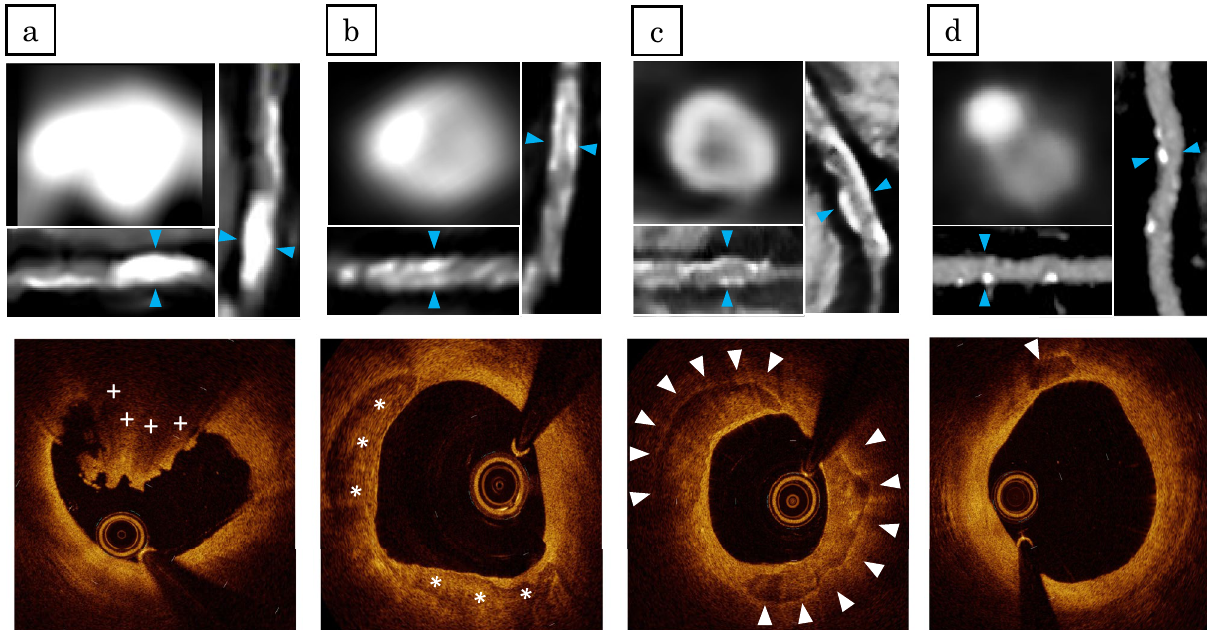
Figure 2. Representative CCTA and OCT images of calcified plaques. ( a ) A representative image of calcified nodule. CCTA image showing a large area of calcification. The area of calcified plaque on the cross-sectional image (at blue arrow heads) is 21.77 mm 2 . The OCT image of this lesion demonstrates calcified nodules (plus symbols). ( b ) A representative image of eccentric calcified plaque. The area of calcified plaque on the cross- sectional image (at blue arrow heads) is 2.8 mm 2 . The OCT image of this lesion demonstrates a superficial calcific sheet (asterisks). ( c ) A representative image of circumferential calcified plaque. CCTA image showing a circumferential calcification. The aread of calcified plaque on the cross-sectional image (at blue arrow heads) is 3.8 mm 2 . The OCT image of this lesion demonstrates a circumferential calcification (white arrow heads). ( d ) A representative image of spotty calcification. CCTA image showing a spotty calcification. The area of calcified plaque on the cross-sectional image (at blue arrow heads) is 0.8 mm 2 . The OCT image of this lesion demonstrated superficial small calcification (white arrow head). CCTA coronary computed tomography angiography, OCT optimal coherence (calcified, non-calcified, low-attenuation, and fibrous plaques) by CT value was completed automatically with SYNAPSE VINCENT version 5.1. The inter-observer reproducilibity measured by Pearson’s coefficient were r = 0.994 to 0.999 for CACS, r = 0.999 for CPV, and r = 0.999 for MCPA (among three investigators; J.S, S.N, and A.O.). The intra-observer reproduc- ibility measured by Pearson’s coefficient were r = 0.999 for CACS, r = 0.999 for CPV, and r = 0.999 for MCPA.